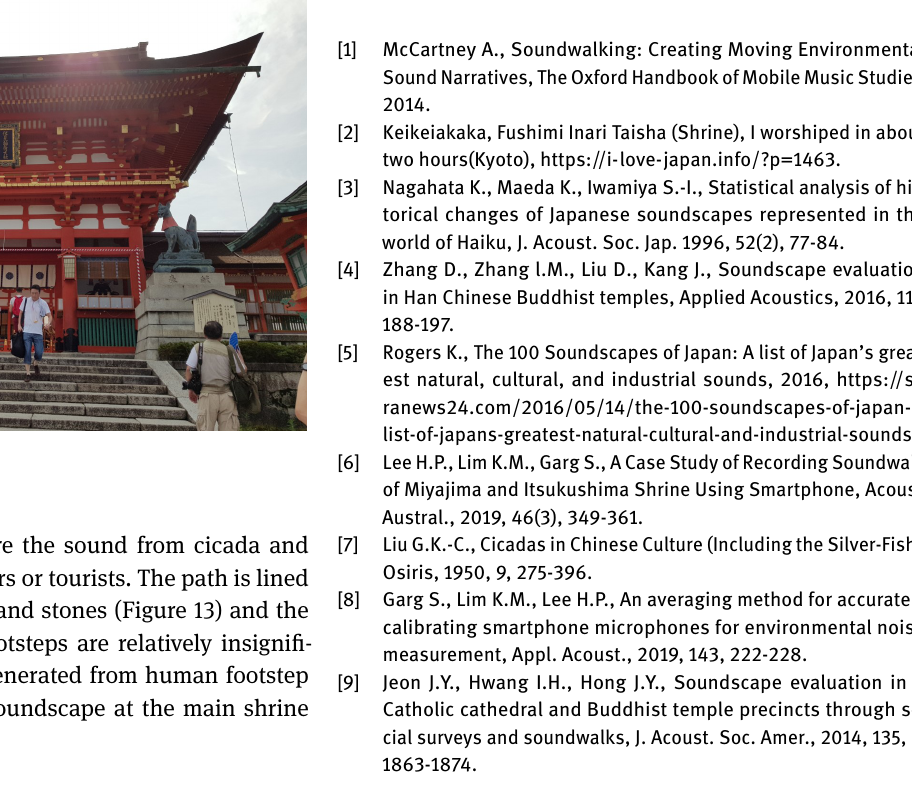
sound sources are therefore the sound from cicada and the chatting from the visitors or tourists. The path is lined by mostly concrete blocks and stones (Figure 13) and the sound from the human footsteps are relatively insignifi- cant compared to sound generated from human footstep on sandy footpaths. The soundscape at the main